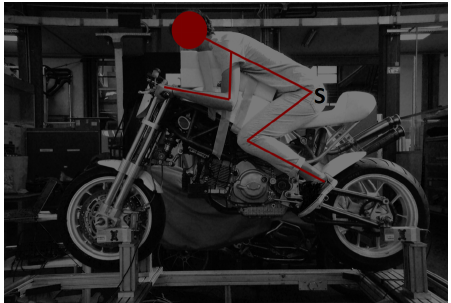
Figure 2. A rider on the test rig, with the main kinematic points used in the multibody model